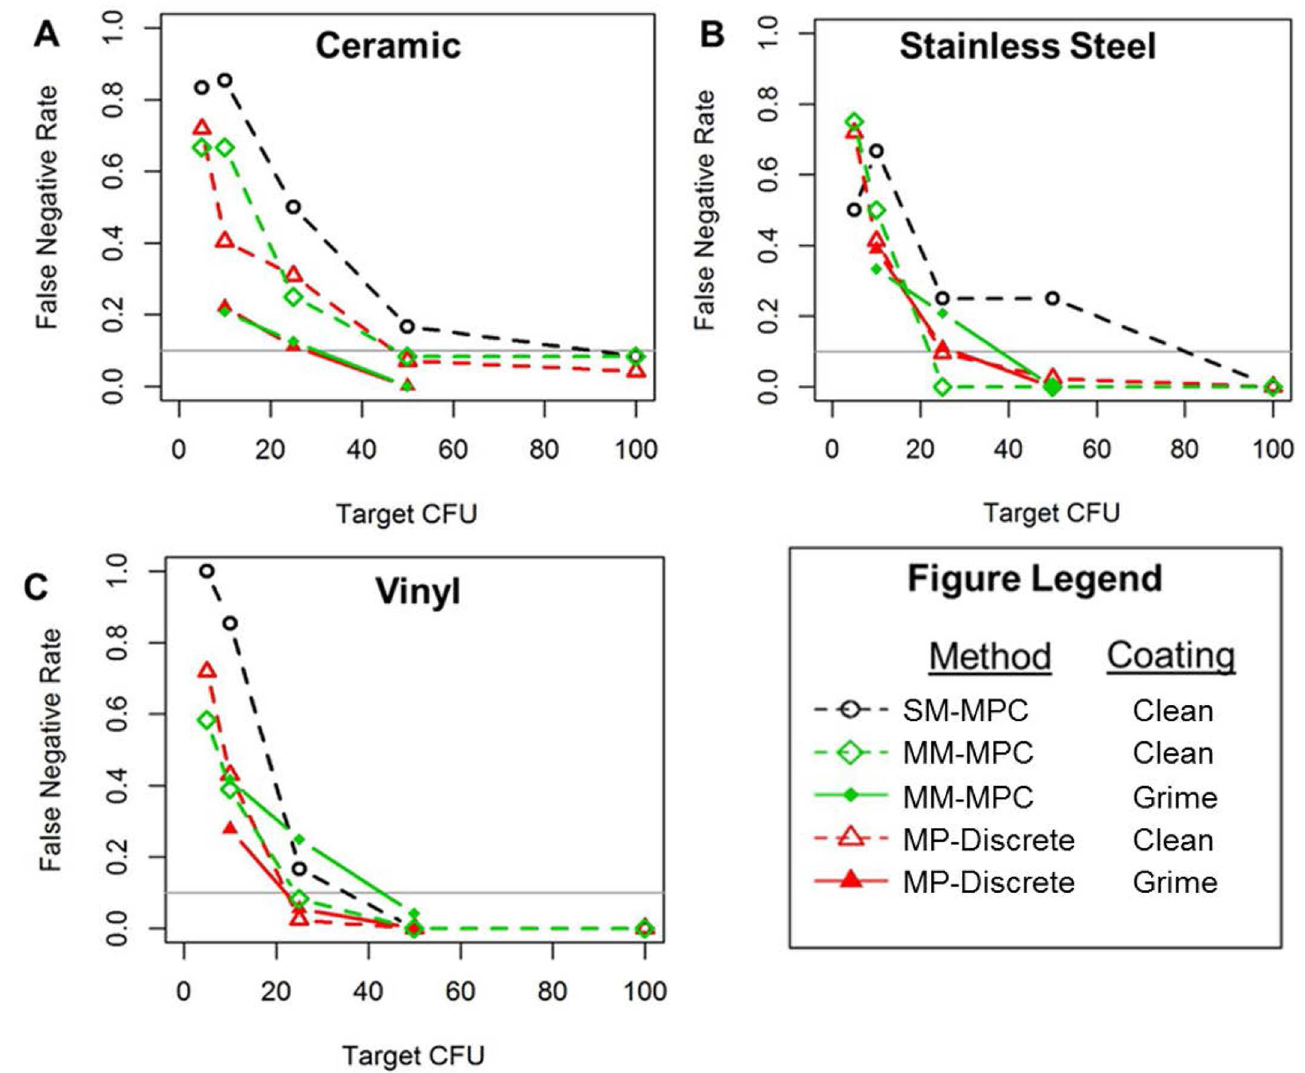
Fig 9. The FNR for the MM-MPC and MP-Discrete methods are similar for grime coated and clean coupons. The highest FNR were associated with the SM-MPC method. FNR decreasesas CFU increases, and is consistently lowest at 100 CFU for ceramic (A), stainless steel (B), and vinyl (C) surfaces that are either clean or grime coated. The gray line in each plot demarcates the 0.1 FNR threshold (i.e., LOD 90 ). The CFU targets used were 5, 10, 25, 50, and 100 CFU per coupon. Coupons were contaminated in four or eight locationsfor the SM-MPC and MM-MPC